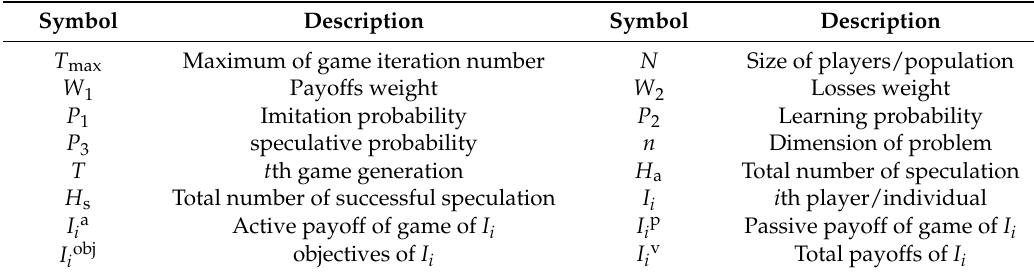
Table 1. Definition of